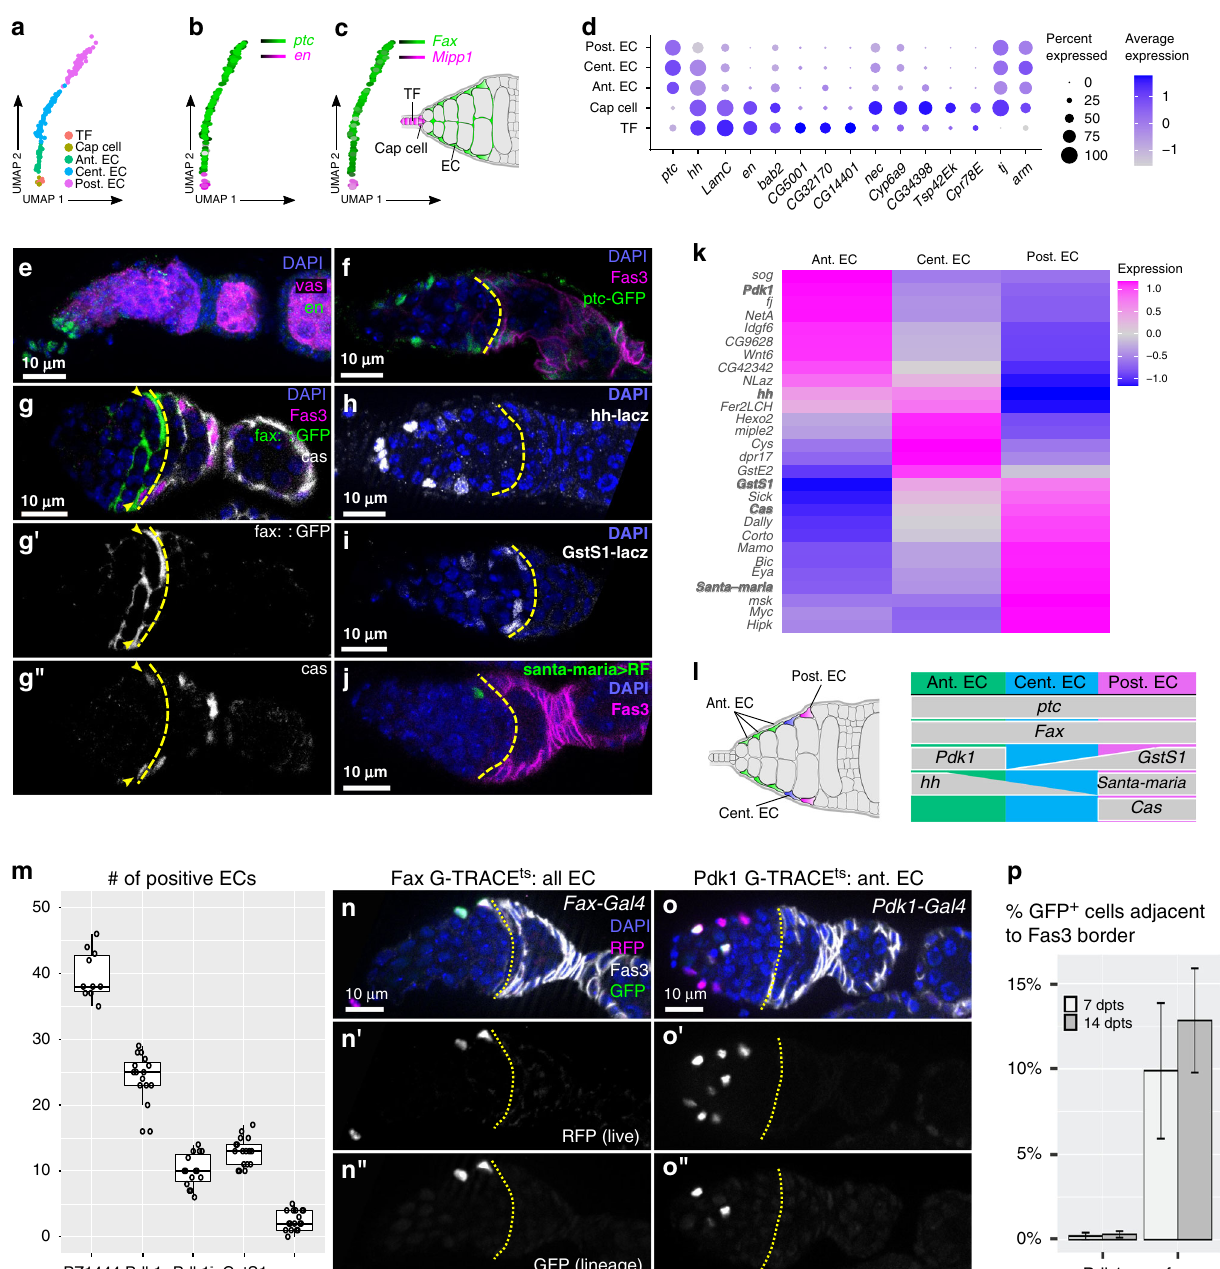
Fig. 3 Anterior germarial somatic cells. a – c UMAP plots of the fi ve clusters that contain somatic cells in the anterior half of the germarium ( a ) and markers that distinguish apical cells (cap cells and terminal fi lament cells) from escort cells ( b – c ). d Dot plot showing the expression of selected markers in each of the fi ve clusters. e – j Wildtype germarium stained for en ( e ), or germaria from enhancer traps or protein traps stained for GFP, RFP, or LacZ as indicated ( f – j ). fax::GFP germaria were also stained for cas (white, g ” ), the GFP channel is shown separately (white, g ’ ). Staining for en, GFP or RFP (green), LacZ (white), Fas3 or vasa (magenta) and DAPI (blue). Yellow dotted line demarks the Region 2a/2b border. k – l Heat map ( k ) and summary diagram ( l ) showing markers distinguishing aECs, cECs, and pECs. m Quanti fi cation of the number of ECs per germarium that express the indicated marker genes. Each dot is a germarium. n = 10, 15, 15, 17, 17 germaria for PZ1444, Pdk1, Pdk1 – , GstS1, and cas, respectively. In the box plots, the midline corresponds to the median; the lower and upper hinges correspond to the fi rst and third quartiles; and the whiskers span the smallest and largest values within 1.5 of the interquartile range. n – o Germaria from fl ies with fax-Gal4 ( n ) or Pdk1-Gal4 ( o ) combined with G-TRACE ts raised at 18 °C, shifted to 29 °C upon eclosion, and well-fed for 14 days before dissection, stained for GFP (green), RFP (magenta), Fas3 (white), and DAPI (blue). n ’ , o ’ RFP channel (white). n ” , o ” GFP channel (white). Yellow dotted line demarks the Region 2a/2b border. p Quanti fi cation of the percent of germaria with GFP + ECs adjacent to the Region 2a/2b border (Fas3 expression boundary) in germaria with fax-Gal4 or Pdk1-Gal4 driving G-TRACE ts after 7 or 14 days at 29 °C. n = 380, 865, 81, and 187 GFP + cells adjacent to Fas3 border for Pdk1 7dpts, Pdk1 14 dpts, fax 7dpts, and fax 14dpts, respectively. Error bars indicate S.E.M. TF: terminal fi lament; EC: escort cell; ant.: anterior; cent.: central; post.: